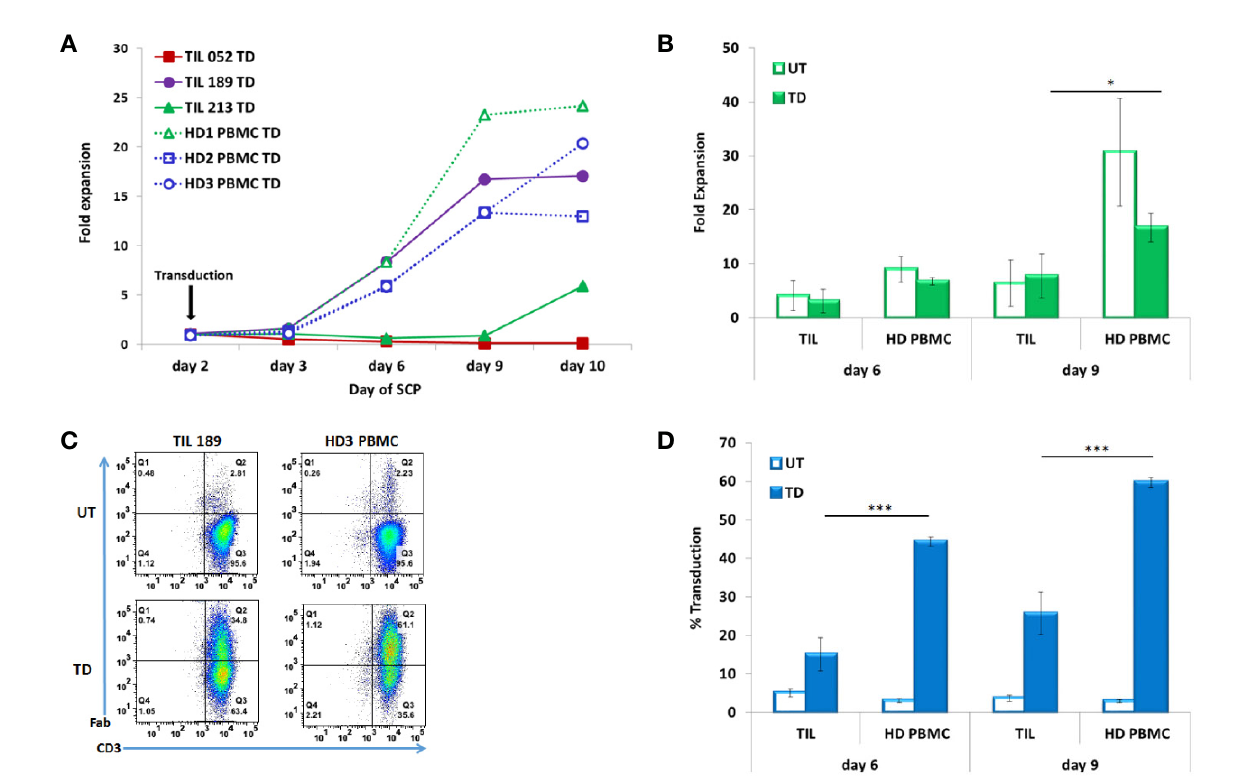
FIGURE 2 | TIL compared to PBMC transduced according to the SCP. (A) Fold expansion after transduction (day 2) of melanoma patients derived TIL (TIL052, TIL189, and TIL213) compared to healthy donor (HD) PBMC (B) Average fold expansion of transduced (TD) and untransduced (UT) TIL and HD PBMC on days 6 and 9. (C) Transduction ef fi cacy determined by CD3/F(ab ′ )2 double positive cells, representative FACS histogram plot (D) Average frequency of transduced TIL and PBMC on days 6 and 9. * p < .05, ***p <